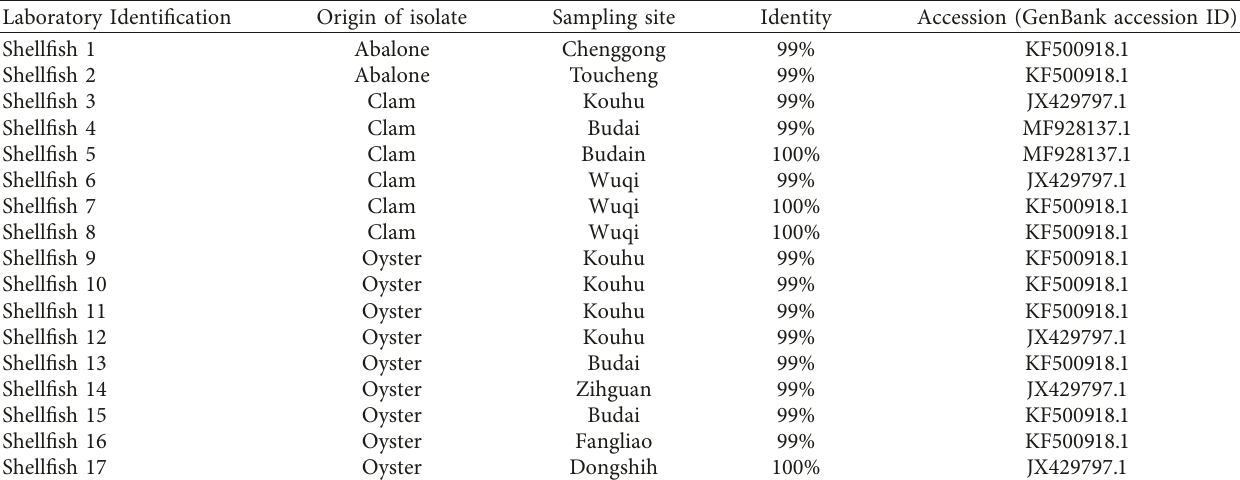
Table 1: Shewanella haliotis isolates,